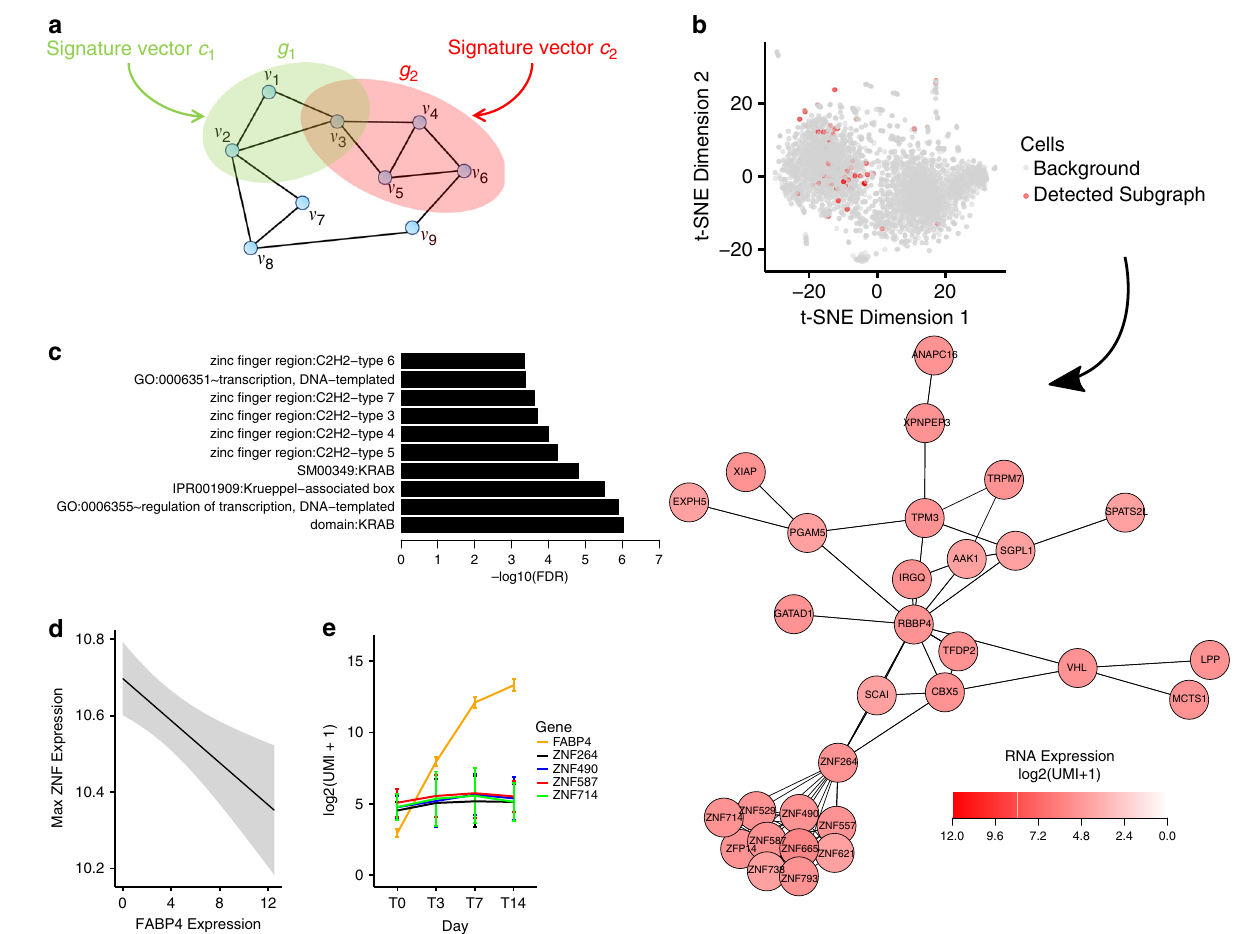
Fig. 3 Subnetwork detection reveals a cluster of ZNFs in adipogenesis. a An overview of the subnetwork detection algorithm where the expression of each gene can be described as the sum of underlying biological networks. b The subnetwork detection algorithm was used to reveal a set of cells primarily found in the left cluster. The detected subnetwork had 30 connected genes. A total of 4319 cells are shown. c Pathway enrichment revealed these 80 genes were enriched in KRAB domains and C2H2 zinc- fi ngers. d The mean of the max expression of the ZNFs ( ZNF264 , ZNF490 , ZNF587 , and ZNF714 ) in the detected cells showed a negative correlation to the adipogenic marker FABP4 . Line indicates mean expression, gray shaded area indicates 95% con fi dence interval. e RNA-seq of whole preadipocyte cultures during differentiation show that the ZNFs do not decrease over time. Bars indicate mean ± s.e.m. N = 2 independent